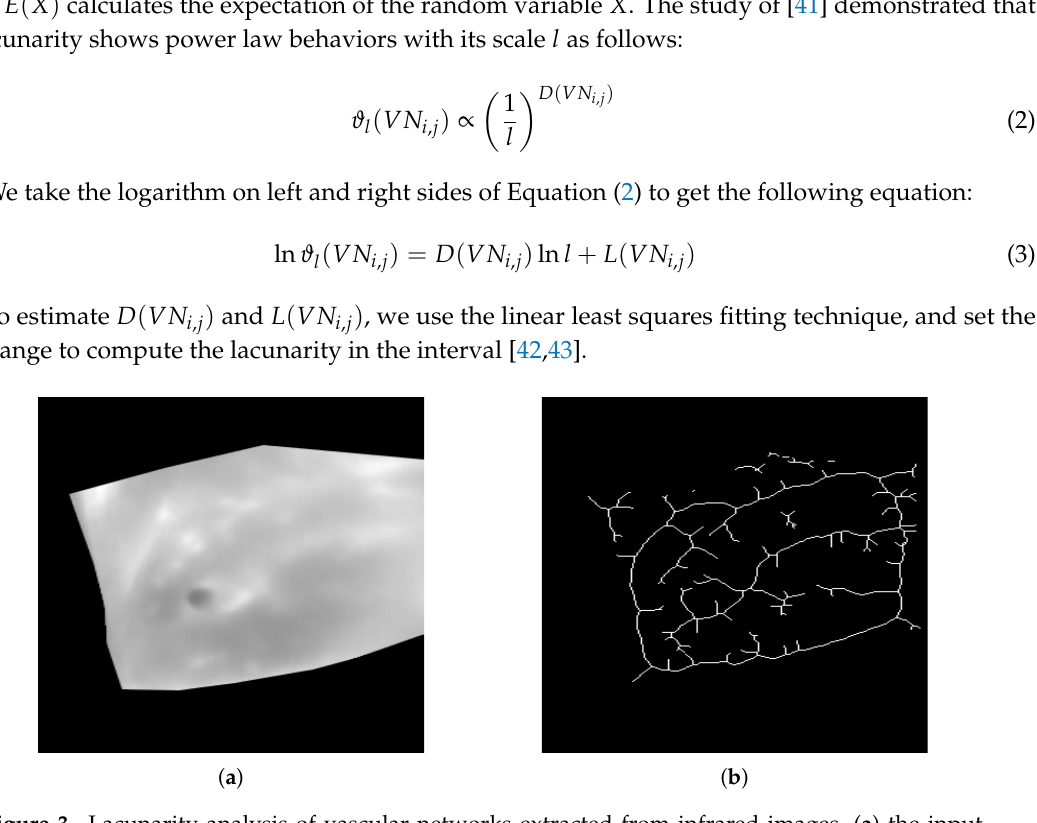
Figure 3. Lacunarity analysis of vascular networks extracted from infrared images, ( a ) the input infrared image, and ( b ) the extracted vascular